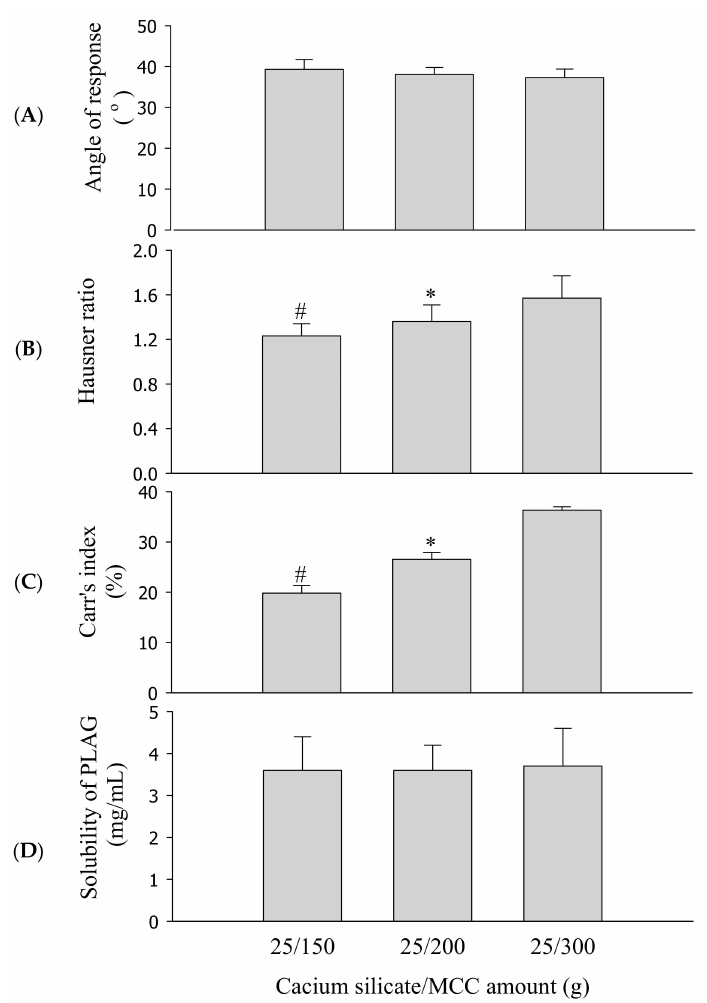
Figure 5. E ff ect of calcium silicate / microcrystalline cellulose (MCC) amounts on the flow ability and solubility of SEGS. Each value represents the mean ± SD ( n = 3). * p < 0.05 compared with calcium silicate / MCC amount (25 / 300 g); # p < 0.05 compared with calcium silicate / MCC amount (25 / 200 and 25 / 300 g). ( A ) Angle of repose; ( B ) Hausner ratio; ( C ) Carr’s index; ( D )